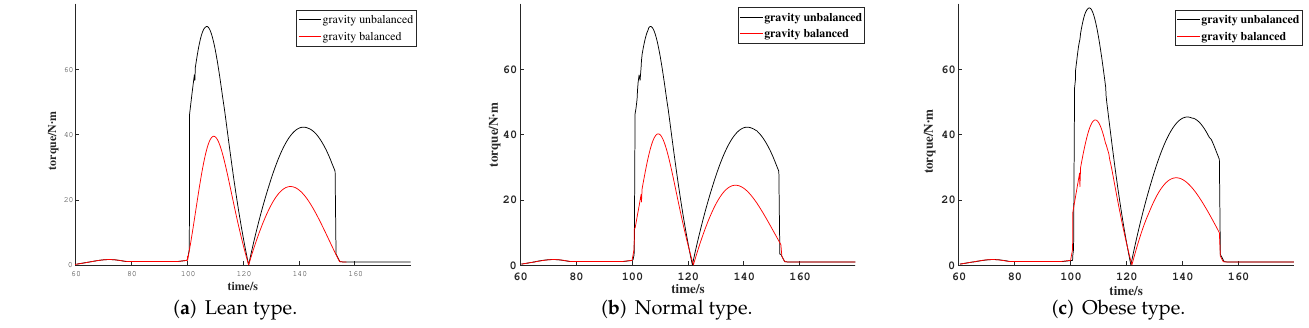
Figure 10. Motor torque variations during hip rehabilitation training with 3 different weights.